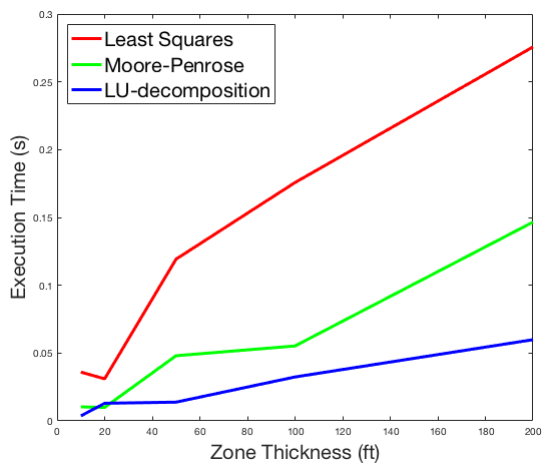
Figure 1. Comparison of average execution times for the three methods: Least squares, LU-decomposition and Moore-Penrose generalized inverse methods, as a function of well zone thickness. An input of three logs is used in all test cases. In general, the execution times increase with zone